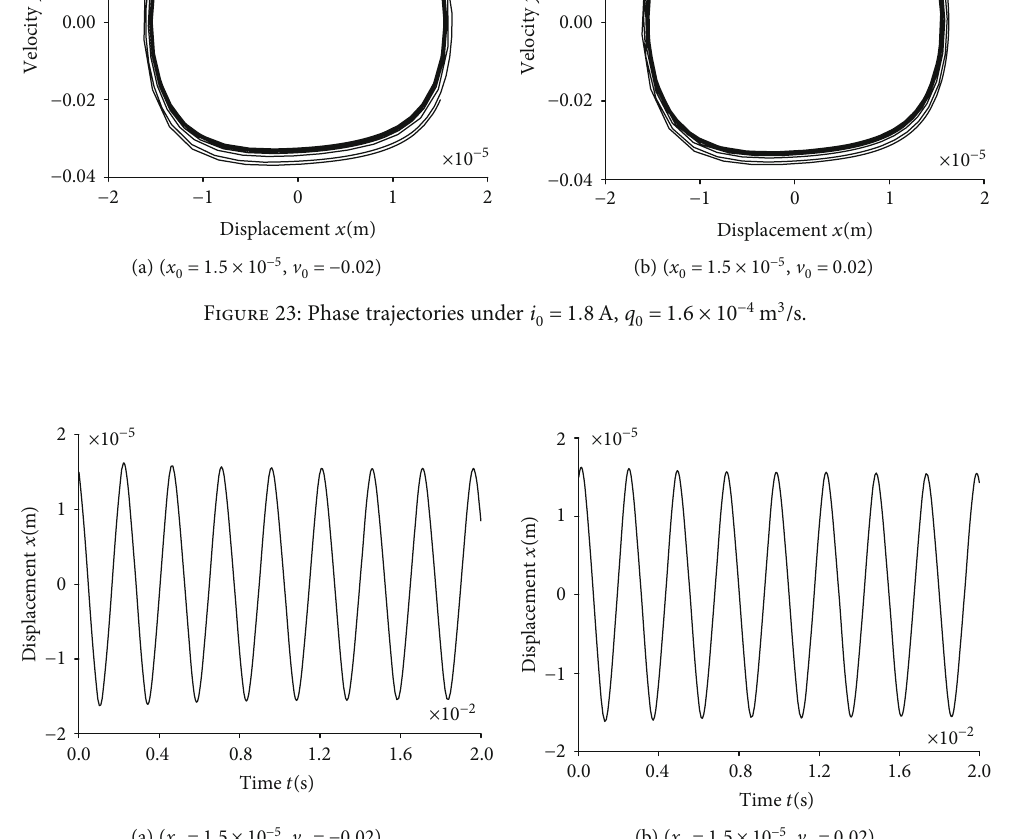
Figure 24: x − t curves under i